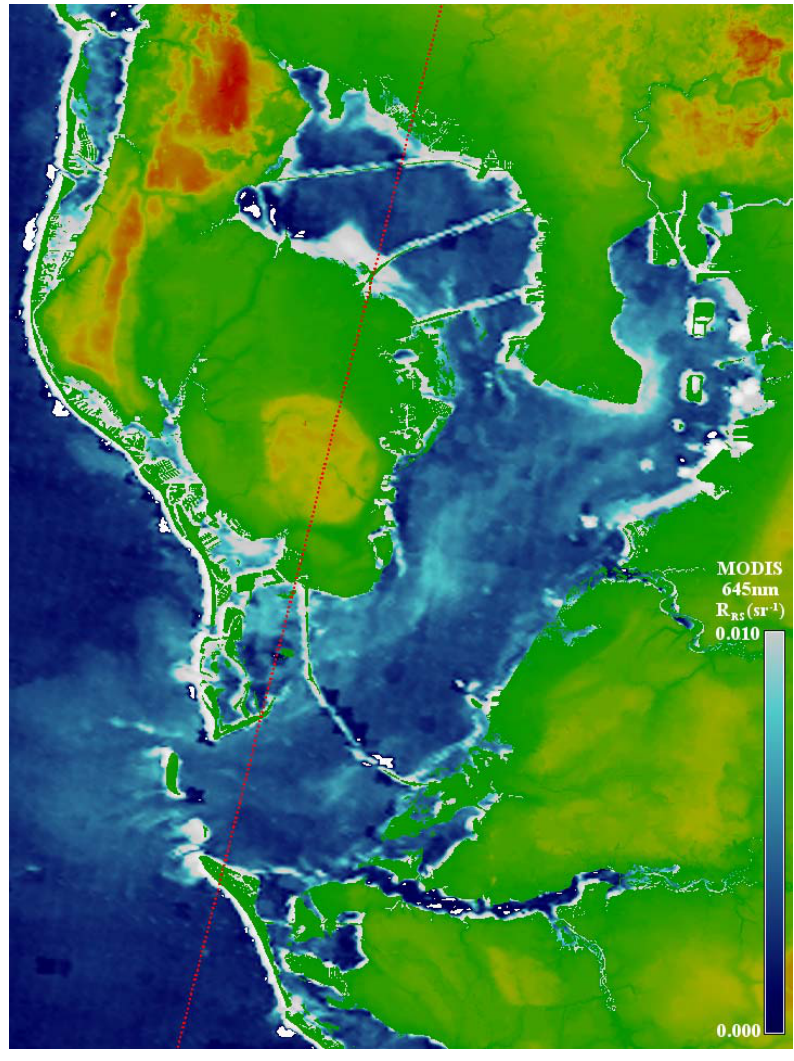
Figure 8. MODIS MOD09 derived 645 nm Remote Sensing Reflectance (R blue and cyan) for 13 October 2007 and the corresponding 14 October 2007 CALIOP shots (red dots). Land was masked using the NOAA Global Self-consistent, Hierarchical, High- resolution Shoreline Database (GSHHS). In this figure, it has been filled with the Global Multi-Resolution Topography Product. The very high values of R are probably due to bottom reflection. The CALIOP footprints are shown larger than actual size for